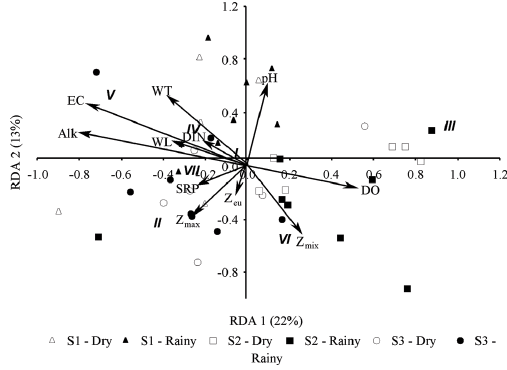
Figure 6. Redundancy analysis (RDA) plot showing the spatial and temporal relationship between the phytoplankton morphology-based functional groups (in bold) and the environmental variables in the studied sites. S1, lake related to the dammed river (Paraná River); S2 and S3, lake related to non-dammed Baia and Ivinhema Rivers respectively. We included only the environmental variables with VIF < 10. Z , maximum max depth; Z , euphotic zone; Z mixing zone; WL, water eu mix level; WT, water temperature; DO, dissolved oxygen; pH; EC, electrical conductivity; Alk, alkalinity; SRP, soluble reactive phosphorus; DIN, dissolved inorganic